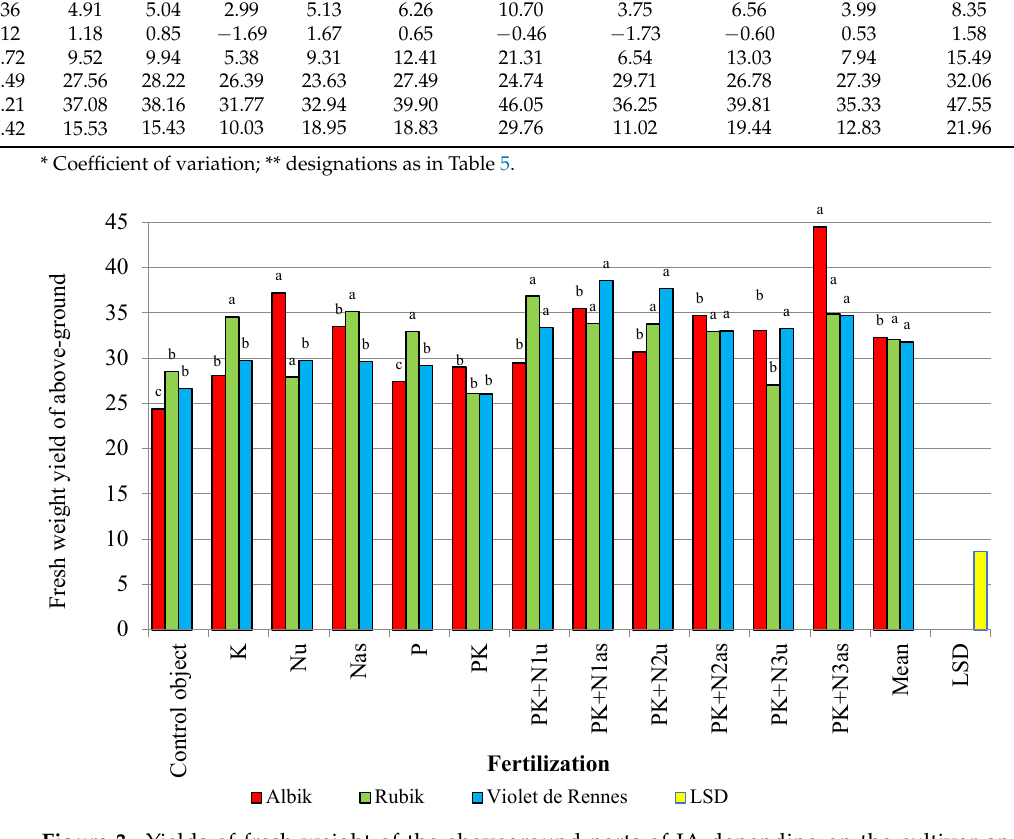
Figure 3. Yields of fresh weight of the aboveground parts of JA depending on the cultivar and mineral fertilization (average in 2016–2018). Legend: control object—N 0 P 0 K 0 ; P—43 kg P · ha − 1 ; K—124 kg K · ha − 1 ; as—ammonium sulfate; u—urea; Nu and Nas—100 kg N · ha − 1 ; PK—P 43 K 124 ; N1— 50 kg N · ha − 1 ; PK+N1—N 50 P 43 K 124 ; N2—100 kg N · ha − 1 ; PK+N2—N 100 P 43 K 124 ; N3—150 kg N · ha − 1